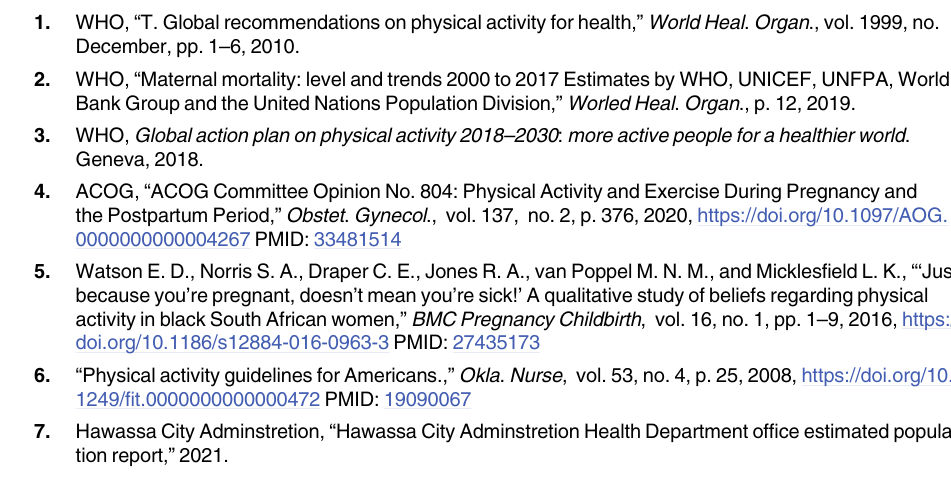
S1 Fig. Schematic presentation of sampling procedure of pregnant women in Hawassa city, Sidama Region, Ethiopia, 2021. S2 Fig. Pregnant women’s practice level on antenatal physical exercise during pregnancy at Hawassa city, Sidama Region, Ethiopia,